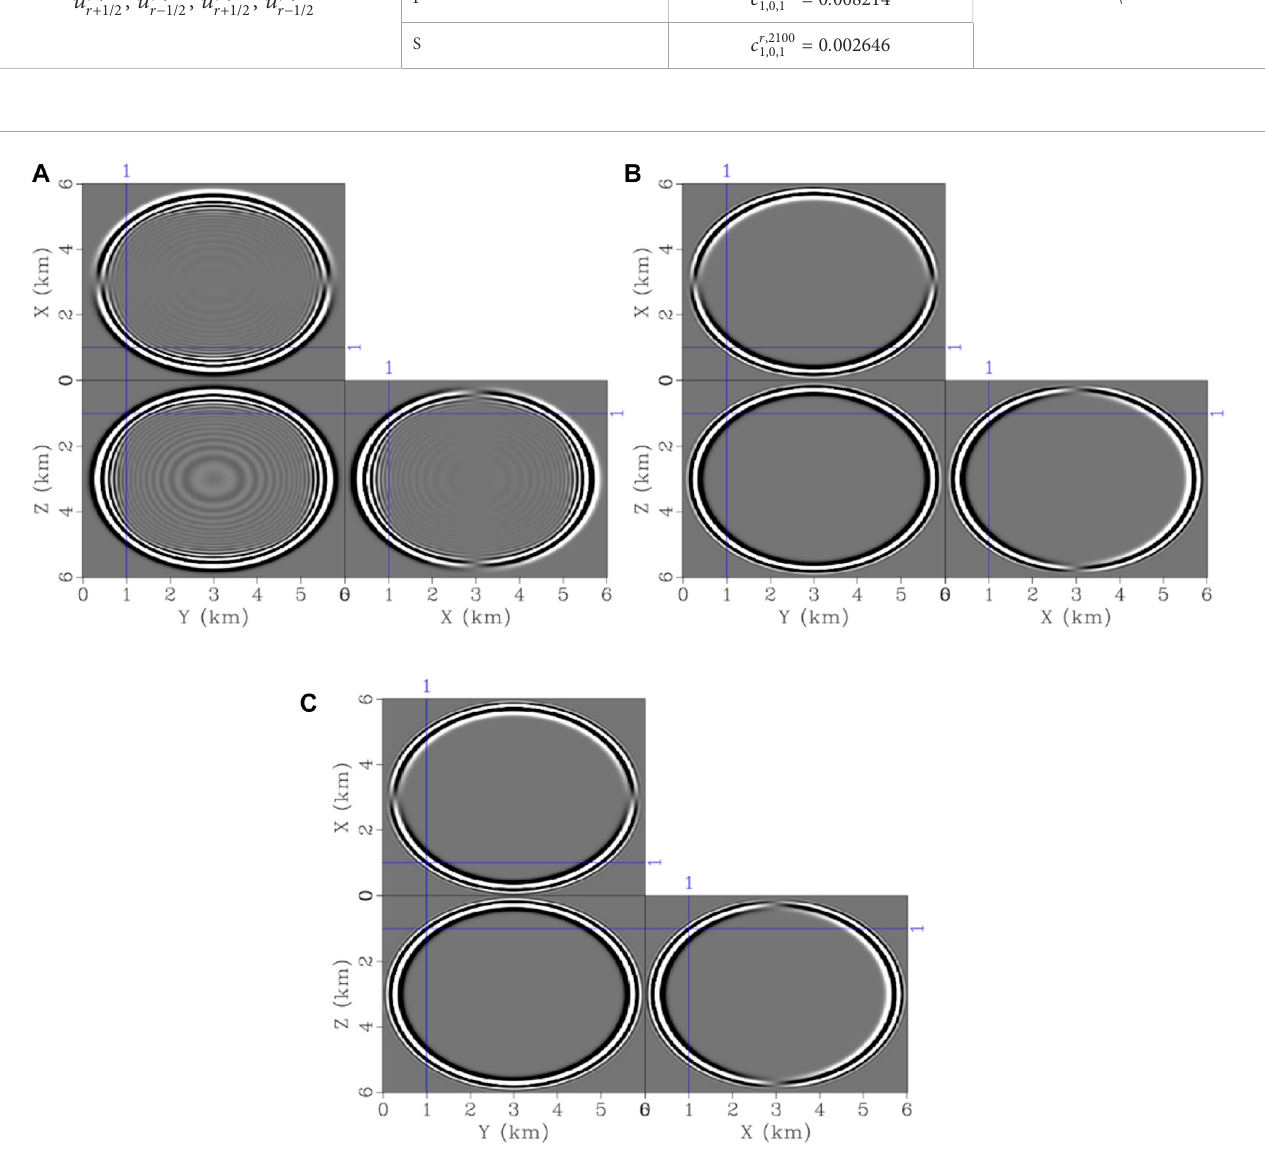
FIGURE 2 Wave fi eld snapshots v x obtained using the STS with the SGFD order of 2 Nr = (A) 2, (B) 4 and (C) 6, at 0.96 s with a time step of 2.4-ms time marching.